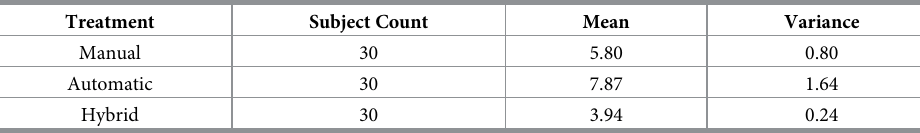
Table 9. Data summary—Viewpoint #1.